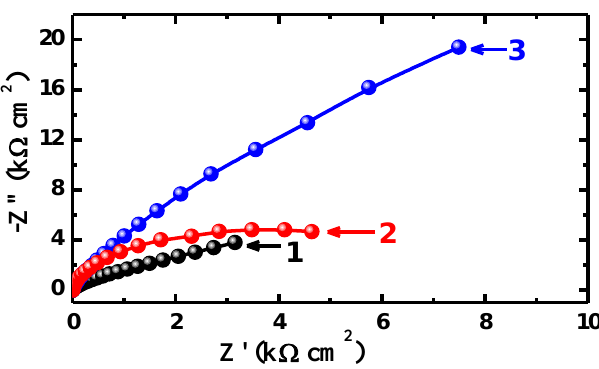
Figure 1. Nyquist plots obtained for (1) hot swaged; (2) annealed at 800 °C; and (3) annealed at 940 °C Ti-45M electrodes after their immersion for 1.0 h in 2 M HCl solutions. Metals 2017 , 7 , 29